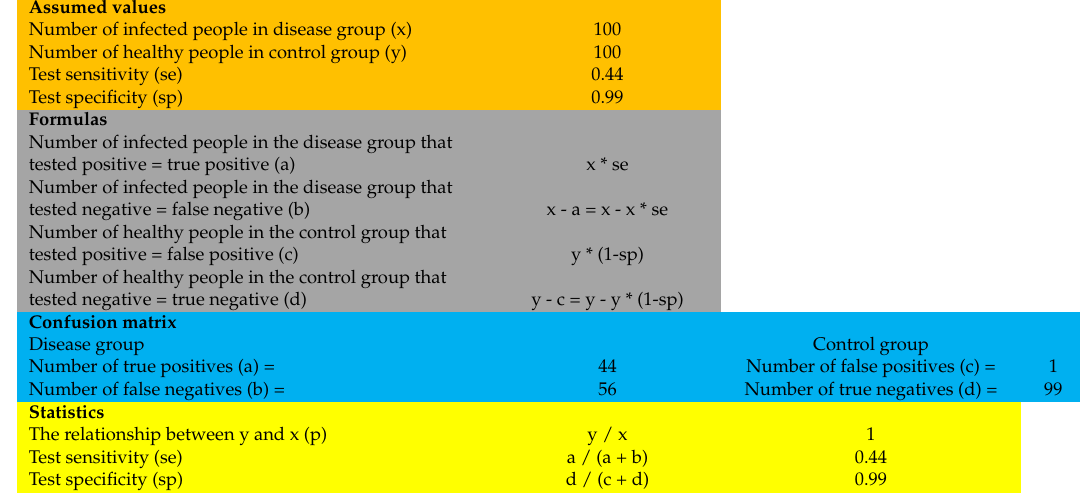
Table 1. Number of people that tested positive in both groups (z) when the number of infected people in the disease group (x) and the number of healthy people in control groups (y) are known and assumed to be